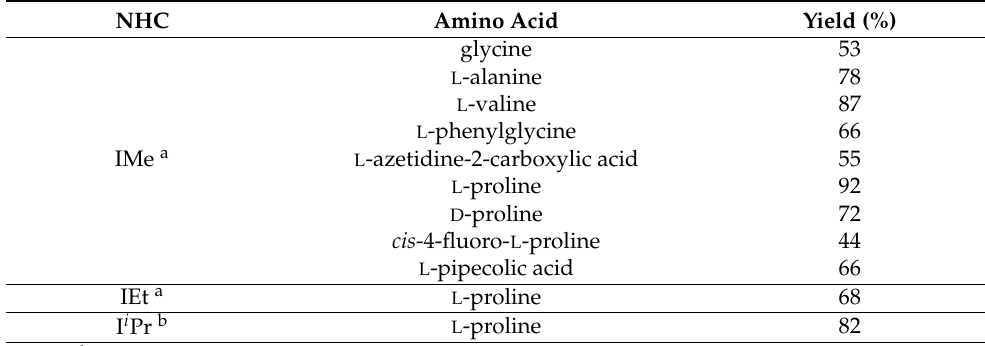
acids, where aa = chelated amino acid and X = halide. Table 1. Scope and synthetic yields of iridium NHC amino acid complexes featured in this